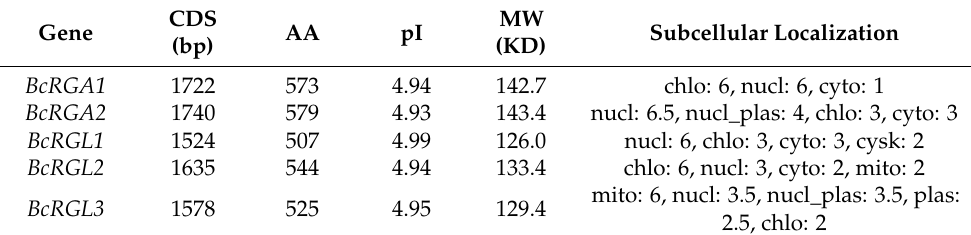
Table 1. Physicochemical properties of DELLA genes in flowering Chinese